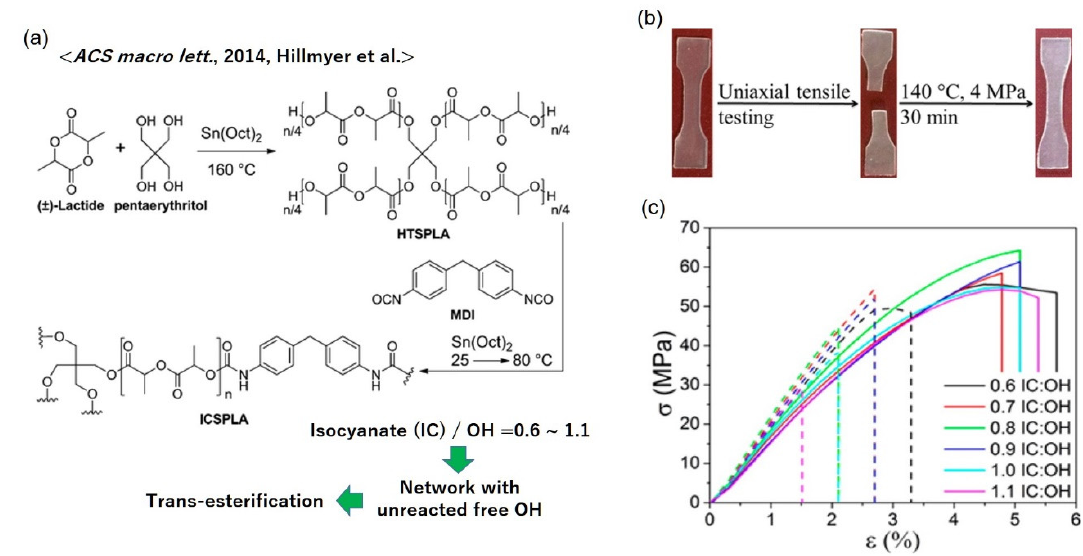
Figure 10. ( a ) Molecular design of polylactide vitrimers according to ref. [53]. The visual representation of healing and the healing level are shown in ( b ) and ( c ), respectively. In ( c ), the stress –strain curves ( σ vs. ε ) are summarized for the pristine (solid lines) and healed (broken lines) samples, where the IC:OH represents the ratio of isocyanate (IC) and OH groups in the feed. Adapted with permission from ref. [53]. Copyright (2014) American Chemical Society.